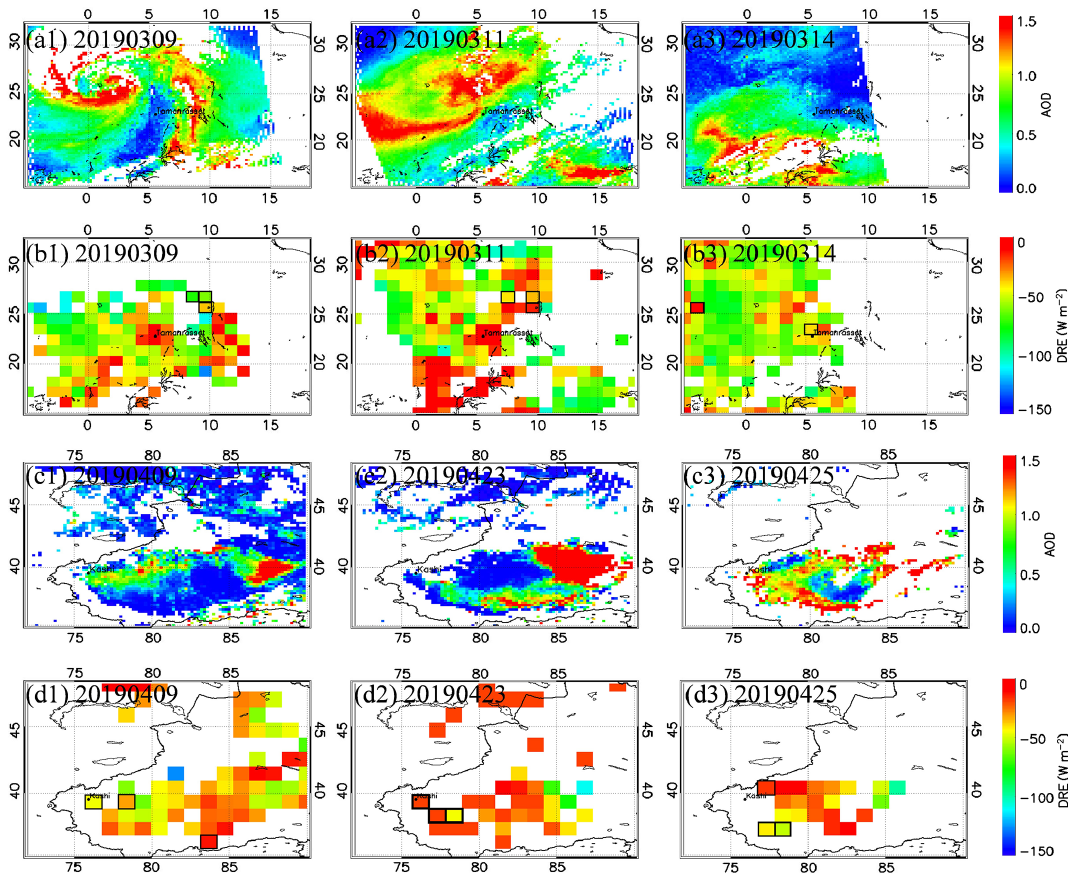
Figure 6. AOD and DRE dust of dust storms over the Sahara in March 2019 and over the Taklimakan Desert in April 2019.